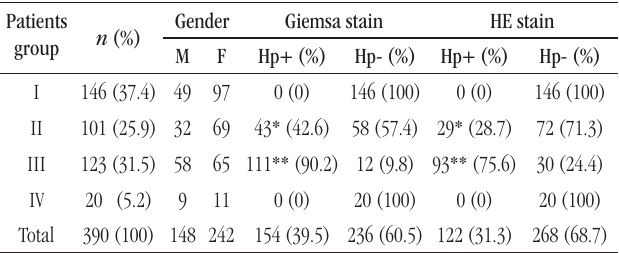
taBLE 1 − Distribution of the 390 patients according the histology of gastric mucosa (Groups I-IV), gender, and Hp positive and negative staining results by Giemsa and HE